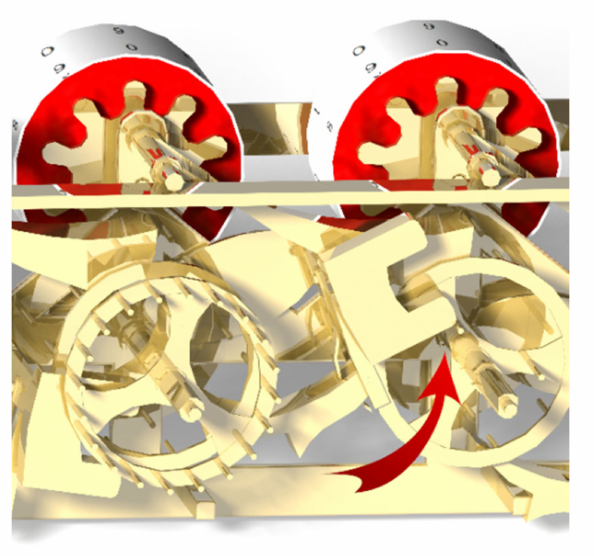
Figure 16. Highest point of upward movement of the carry